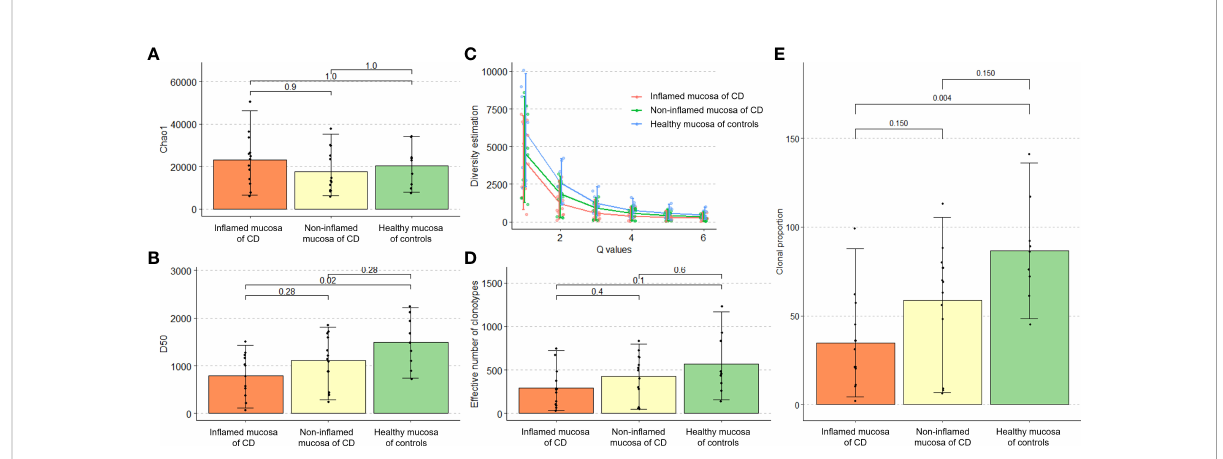
FIGURE 2 Richness and diversity of TCR repertoire in patients with Crohn ’ s disease and non-IBD controls. (A) Alpha diversity measured by the Chao1 richness estimator. (B) Hill number diversity index. (C) D50 diversity index. (D) True diversity index. (E) Number of clonotypes occupying 10% of the TCR repertoire.